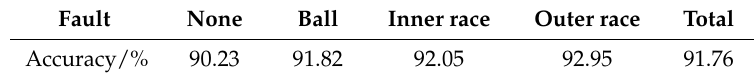
Table 10. Accuracy of four fault conditions at full rotating speeds using